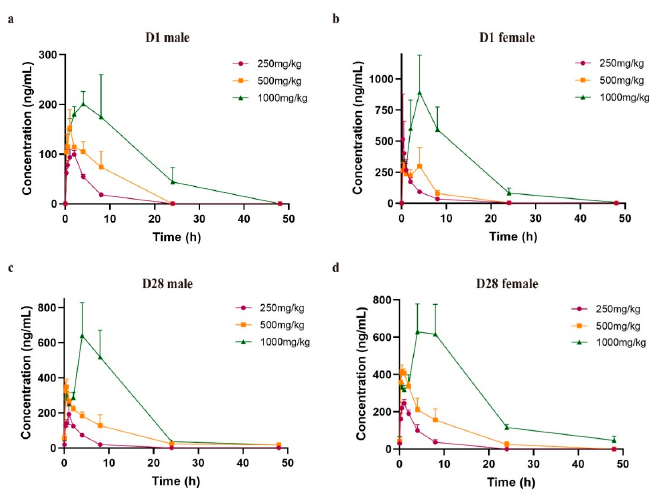
Figure 3. Mean plasma concentration–time profiles of SD rats after oral administration 250 mg/kg, 500 mg/kg, and 1000 mg/kg PQQ disodium salt: ( a , b ) plasma concentration of PQQ disodium salt in males and females on day 1; ( c , d ) plasma concentration of PQQ disodium salt in males and females on day 28. Each point and bar represent the means ± SEM (n = 3). Concentrations below the LLOQ (BQL) are presented as a concentration of 0 ng/mL to maintain the integrity of the curves and are excluded from statistics of pharmacokinetic parameters. Table 6. Toxicokinetic parameters of PQQ after single and 28-day repeated administration in rats at 250 mg/kg, 500 mg/kg and 1000 mg/kg dose level. Dose